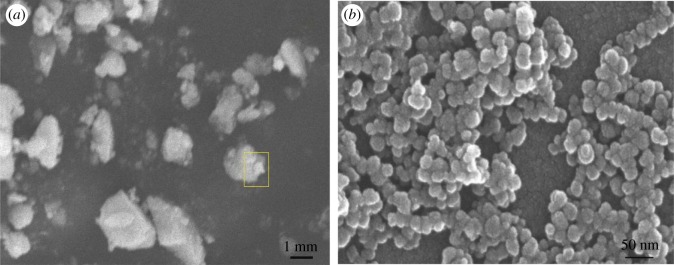
(a) SEM image of 1.0%Tb–TiO2 composite and (b) a magnified image of the highlighted portion in (a).